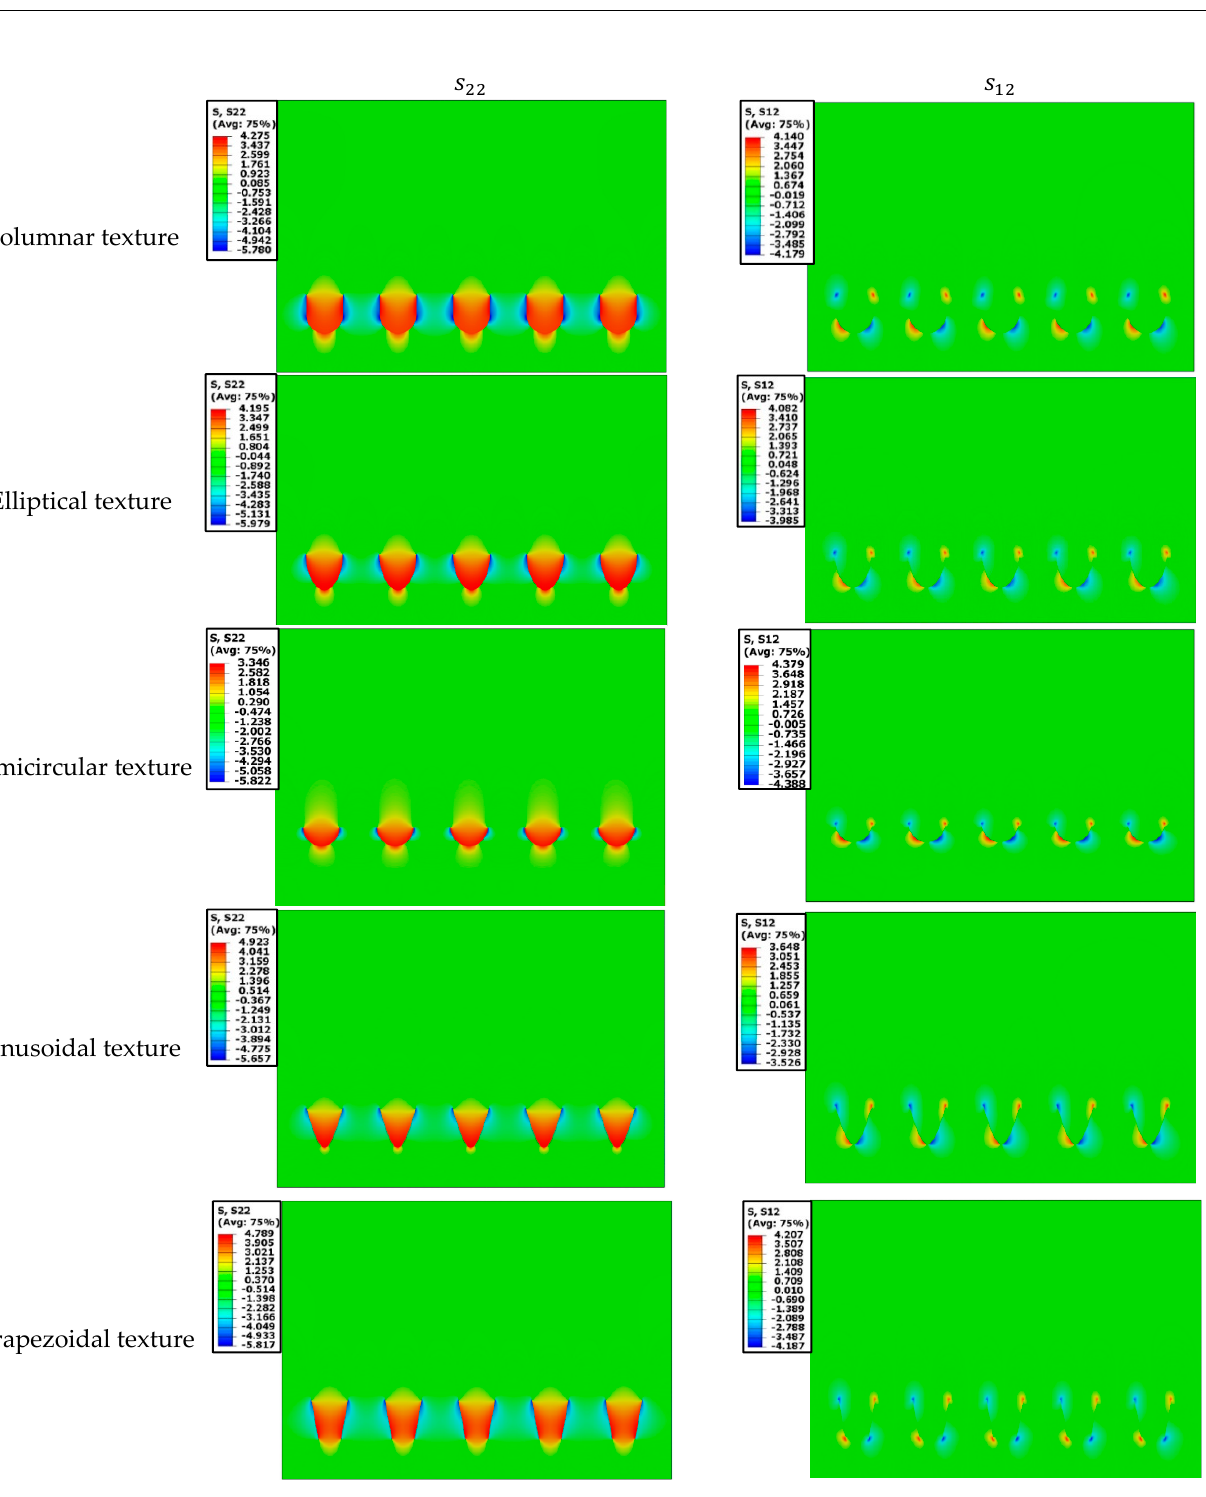
Observing the prestress field s 22 perpendicular to the interface, the texture in the TC layer is subject to positive tensile stress, with a maximum value of about 4 MPa. Except for the semicircular texture being different from the other textures in depth, the maximum tensile stress is 3.346 MPa, and the maximum tensile stress and maximum compressive stress are near the cusp formed by geometric mutation. For the texture in the BC layer, the maximum tensile stress appears at the bottom of the texture, and the maximum compressive stress appears near the cusps at both ends of the texture.